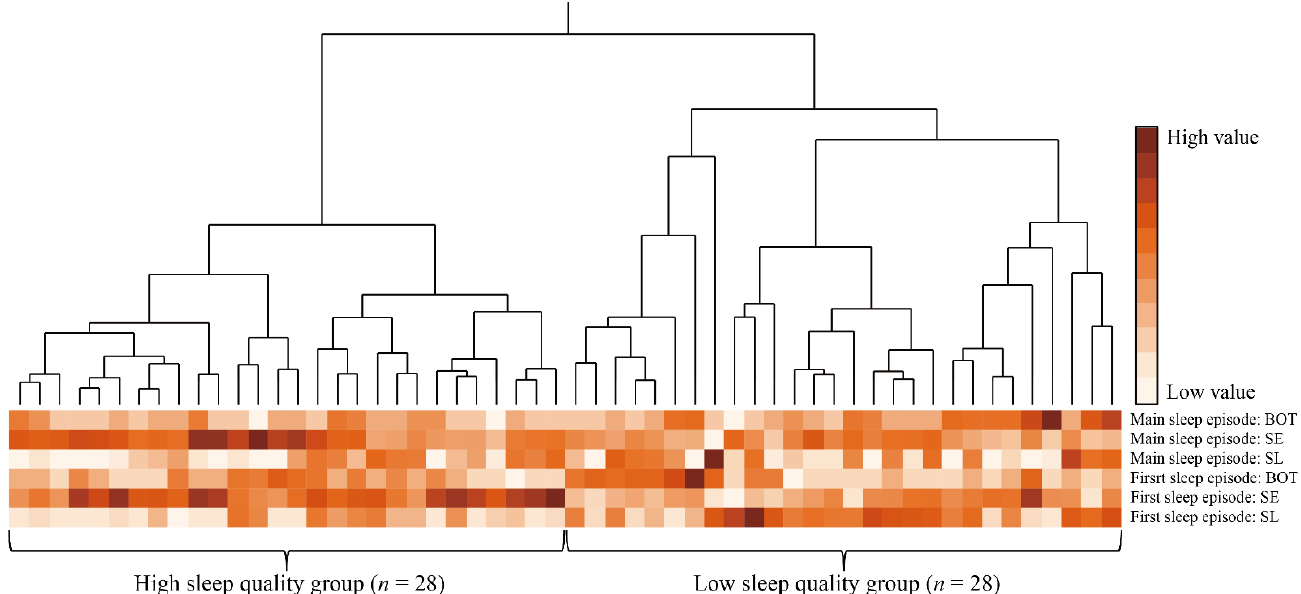
Figure 2. Dendrogram and heatmap of hierarchical cluster analysis with Ward’s method. Abbreviations : BOT, the interval between the last sleep onset and the change in posture from lying to standing; SE, percentage of total sleep time for the time at which the posture involved lying; SL, the interval between changing posture from standing to lying and the start of the sleep episode. Notes : color scales represent value size in each sleep variable; each column represents a participant and each row represents sleep parameter; high sleep quality group identified by cluster analysis had a sleep profile of shorter SL, higher SE, and shorter BOT in both the first and main sleep episodes; low sleep quality group identified by cluster analysis had a sleep profile of longer SL, lower SE, and longer BOT in both the first and main sleep episodes.